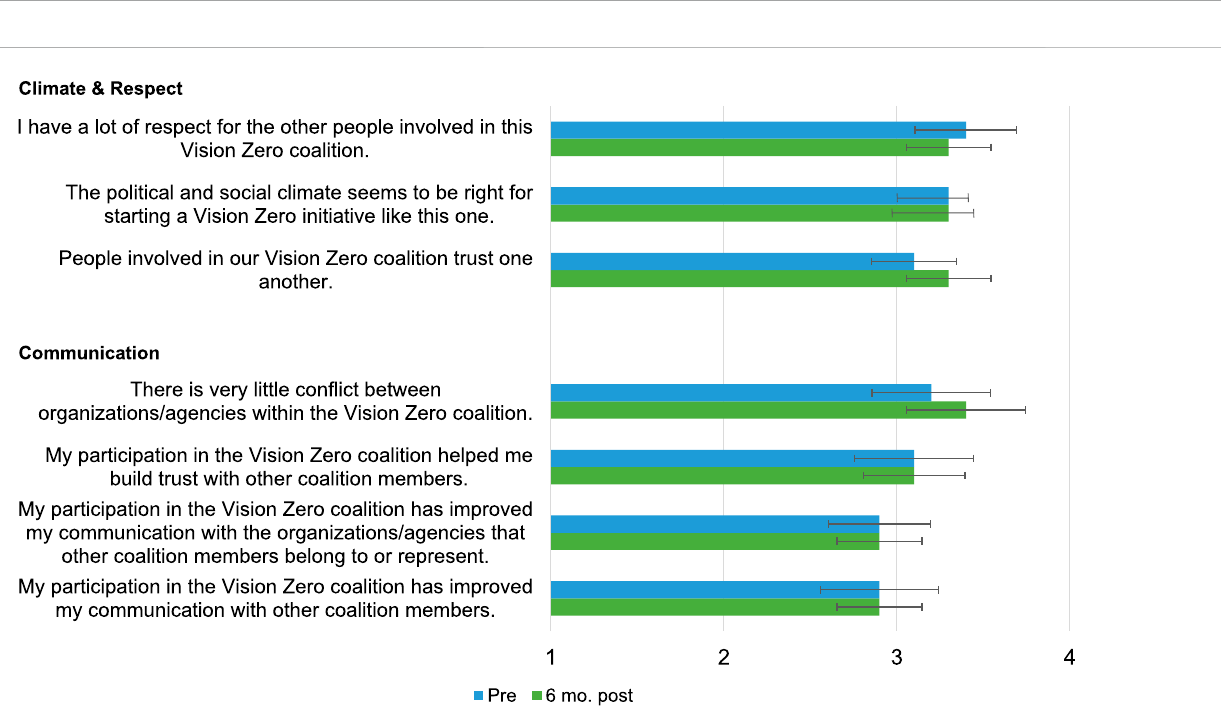
Frontiers in Future